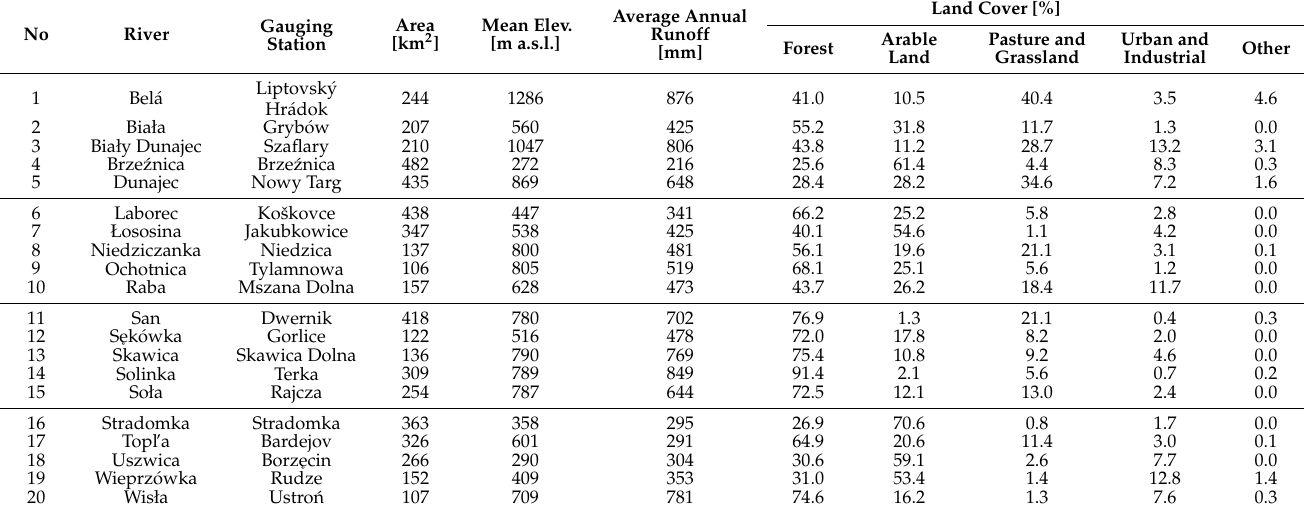
Figure 2. Distribution percentiles for daily runoff in the studied catchments in the period 1970–2019 (catchment ID nos. explained in Table 1).